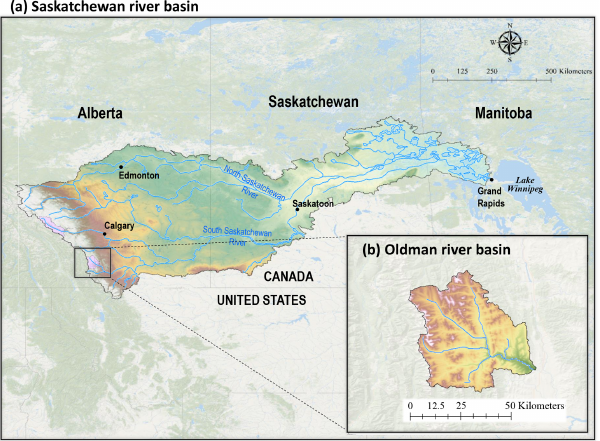
Figure 2. The Nottawasaga River basin in southern Ontario, Canada (adapted from Sheikholeslami et al., 2019, with permission from Elsevier; license number: